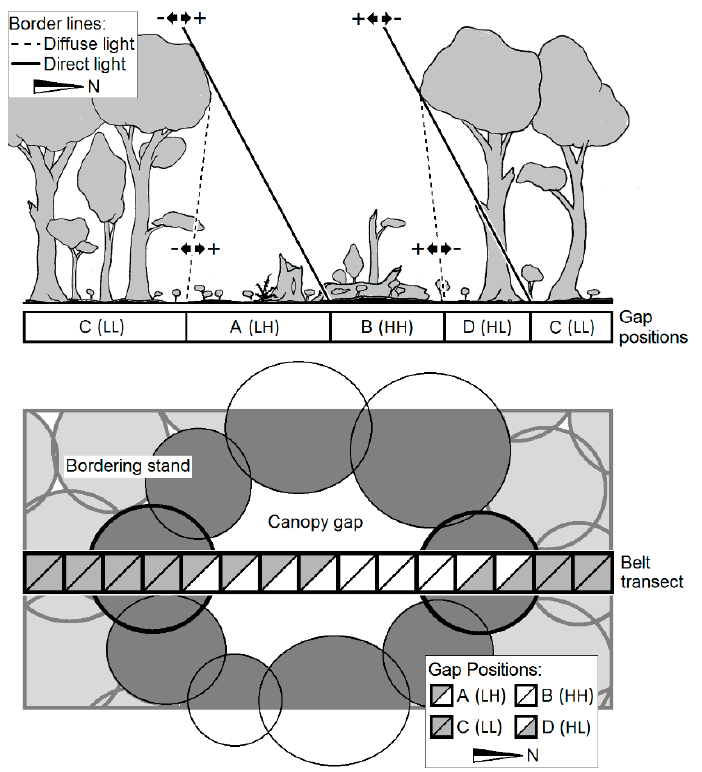
Figure 1. Cross-section in north-south direction and horizontal projection of a schematic canopy gap. The sketches illustrate the categorical zonation of the relative intensities of direct and diffuse radiation along a south-north-directed belt transect and the location of four classes of radiation input on the forest floor (C = low direct and low diffuse radiation ( LL ), A = low direct and high diffuse radiation ( LH ), B = high direct and high diffuse radiation ( HH ), D = high direct and low diffuse radiation ( HL )) according to the conceptual model of Diaci [38] (labelling modified). Table 1. Definition of four light regime classes in a gap (A–D) according to the relative availability of direct and diffuse radiation after Diaci [38]. Gap